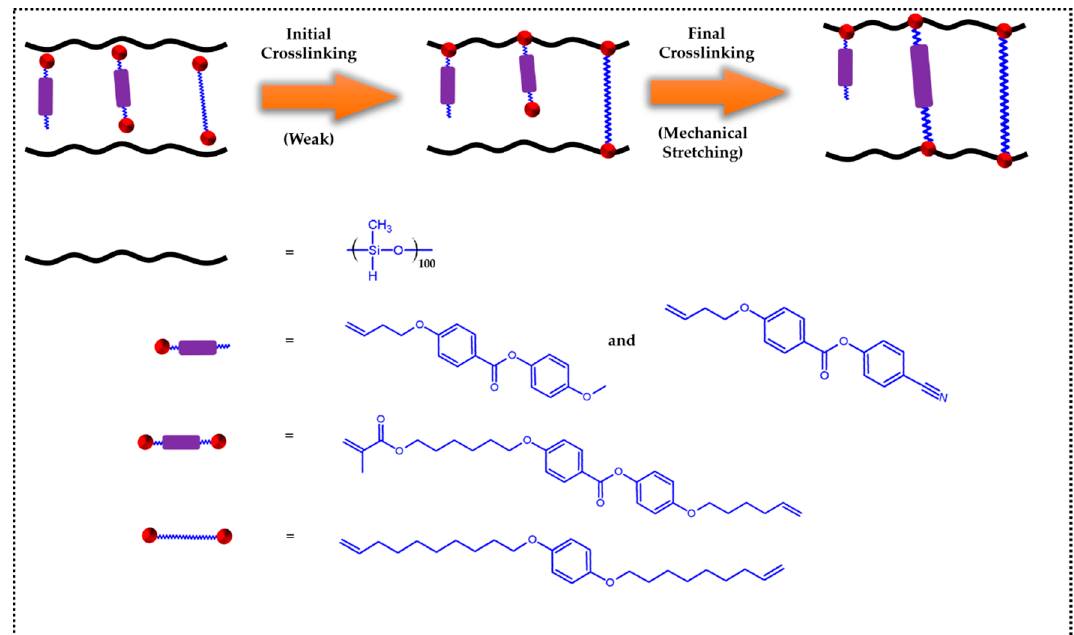
Figure 1. Schematic illustration of synthetic strategy with chemical structures, proposed by Küpfer and Finkelmann for the synthesis of monodomain nematic liquid crystalline elastomers (LCEs) [5].